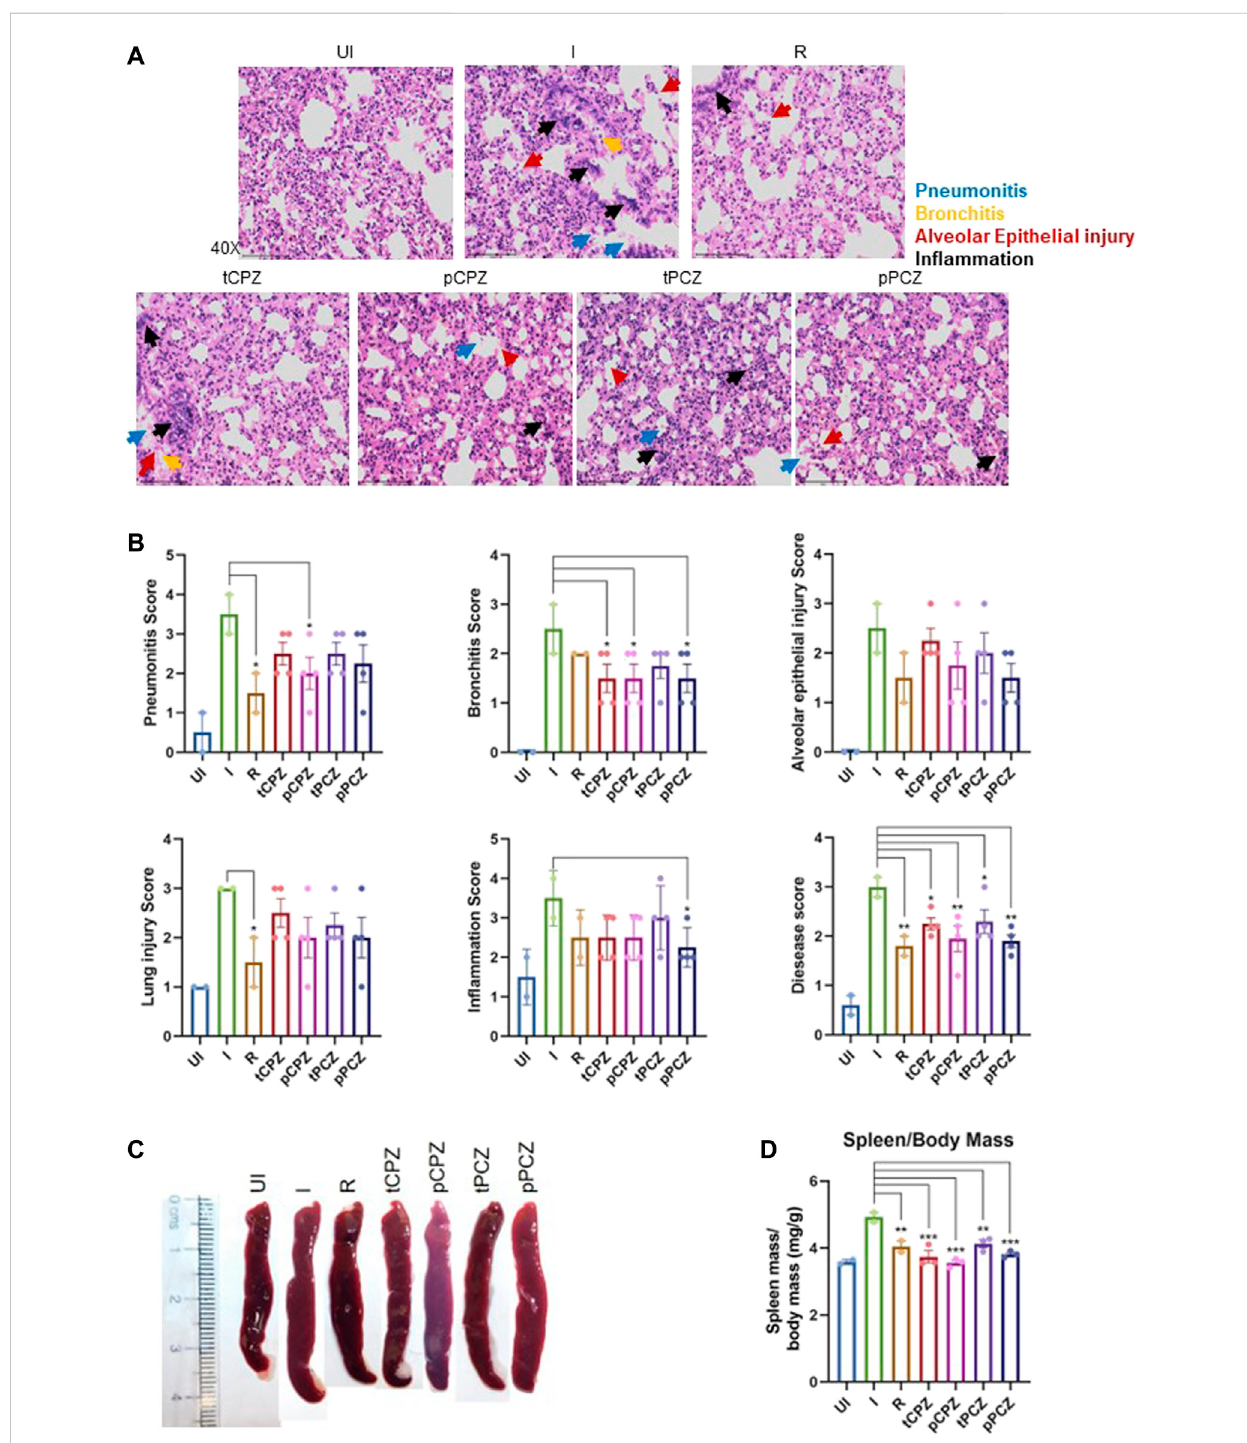
FIGURE 6 Histopathology shows better prognosis in SARS-CoV-2 infected hamsters upon CPZ, PCZ treatment. (A) Images of H&E-staining of excised lungs from hamsters of different treatment groups at ×40 magni fi cation showing regions of pneumonitis (blue arrow), bronchitis (orange arrow), alveolar epithelial injury (red arrow), and in fl ammation (black arrow). (B) Histological score for pneumonitis, bronchitis, alveolar epithelial injury, lung injury, in fl ammation,andoveralldiseasescoreofthelungsafterdifferenttreatments. (C) Representativeimagesofexcisedspleenindicatingchangesinthe spleen length upon different treatments. (D) Spleen mass/body mass (mg/g) of the excised spleen indicating splenomegaly upon different treatments. Mean ± SE (n = 3); ordinary one-way